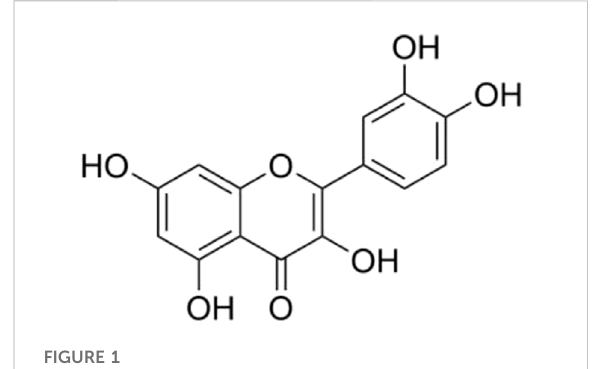
FIGURE 1 Chemical structure of